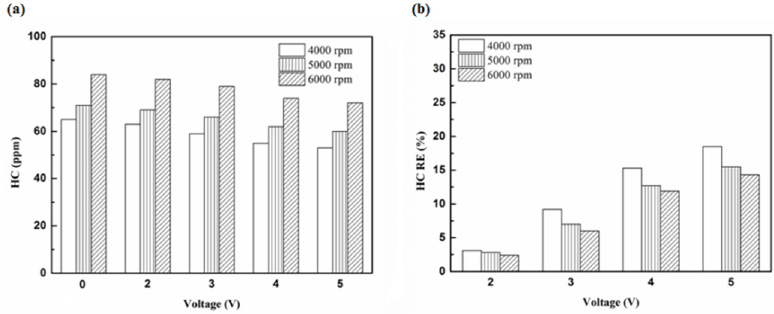
Figure 6. The HC ( a ) emission values and ( b ) RE using iridium alloy in the front of the exhaust pipe.